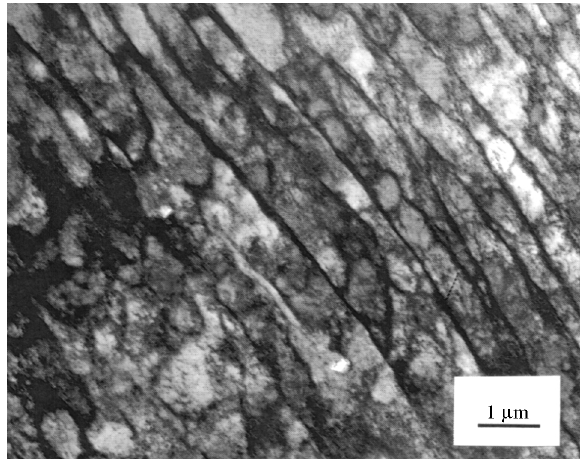
Figure 7. TEM observation of dislocations structure of a specimen drawn in one pass, 8° and